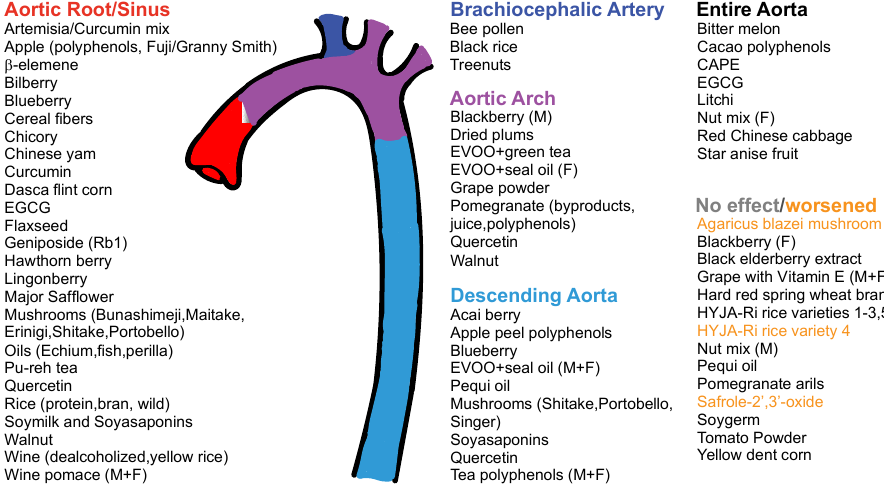
Figure 3. E ff ect of nutritional interventions in plaque accumulation in the aorta. The e ff ect of di ff erent Figure 3. Effect of nutritional interventions in plaque accumulation in the aorta. The effect of different food and extracts in reducing plaque are listed for the aortic arch / sinus, the brachiocephalic artery, the food and extracts in reducing plaque are listed for the aortic arch/sinus, the brachiocephalic artery, descending aorta, and the entire aorta. Foods that showed no e ff ect and the ones that increased plaque the descending aorta, and the entire aorta. Foods that showed no effect and the ones that increased are also listed. Studies using both males (M) and females (F) are also plaque are also listed. Studies using both males (M) and females (F) are also identified.